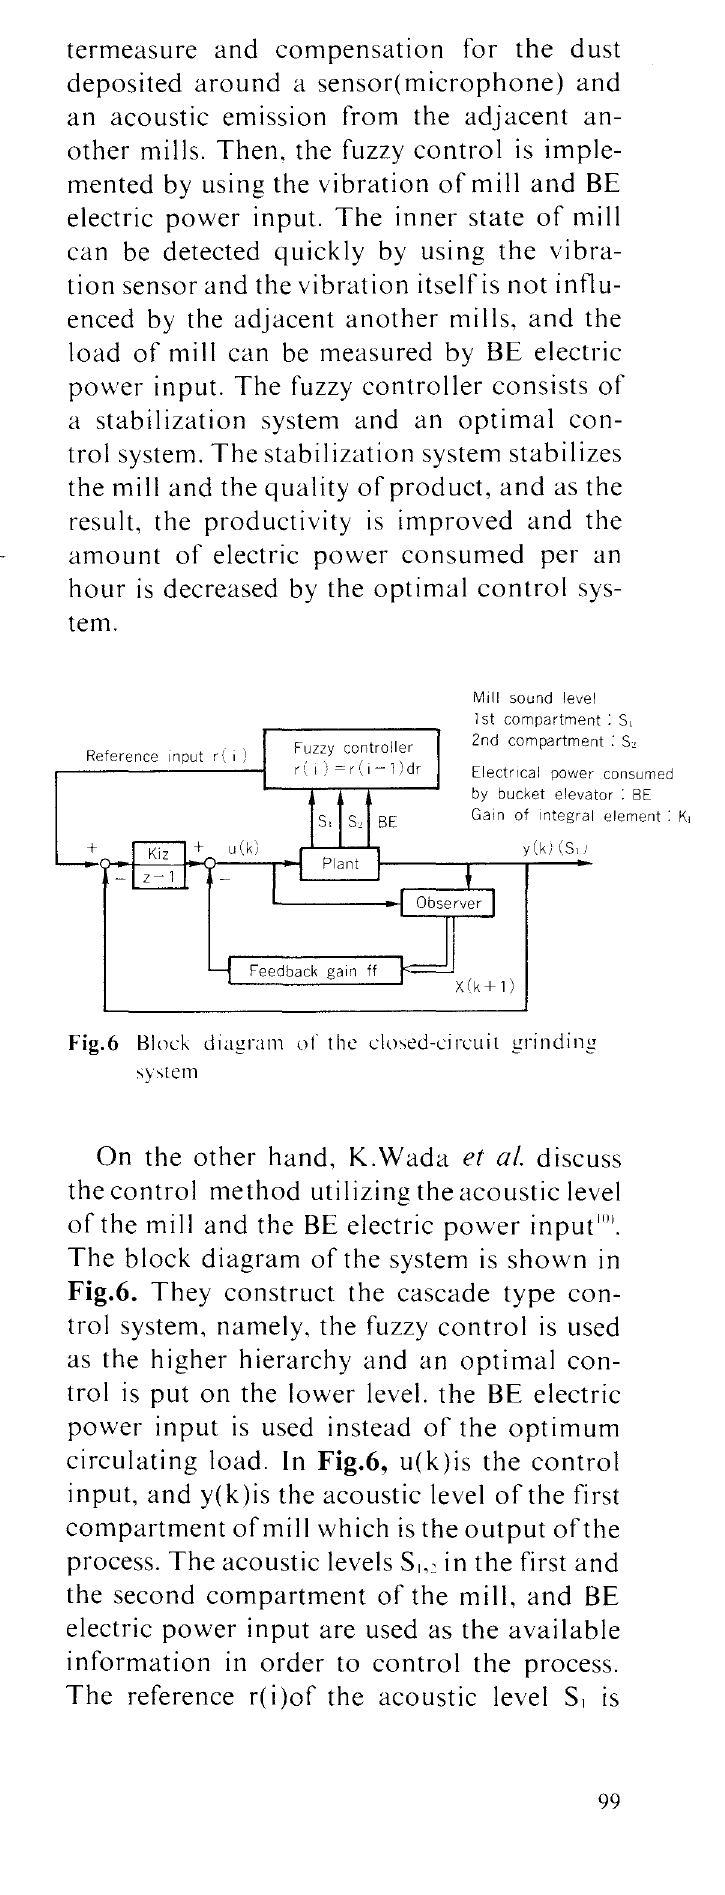
Fig.6 Block diagram of the clo-,cd-circuit grinding